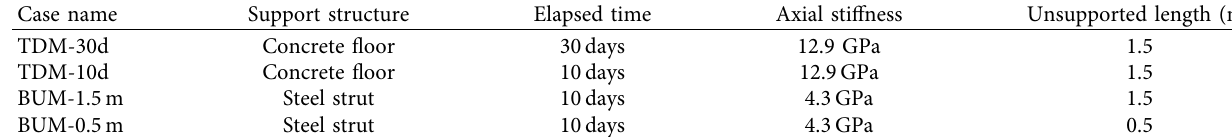
Table 2: Description of the cases considered in Figure 6(b), modified from [35].